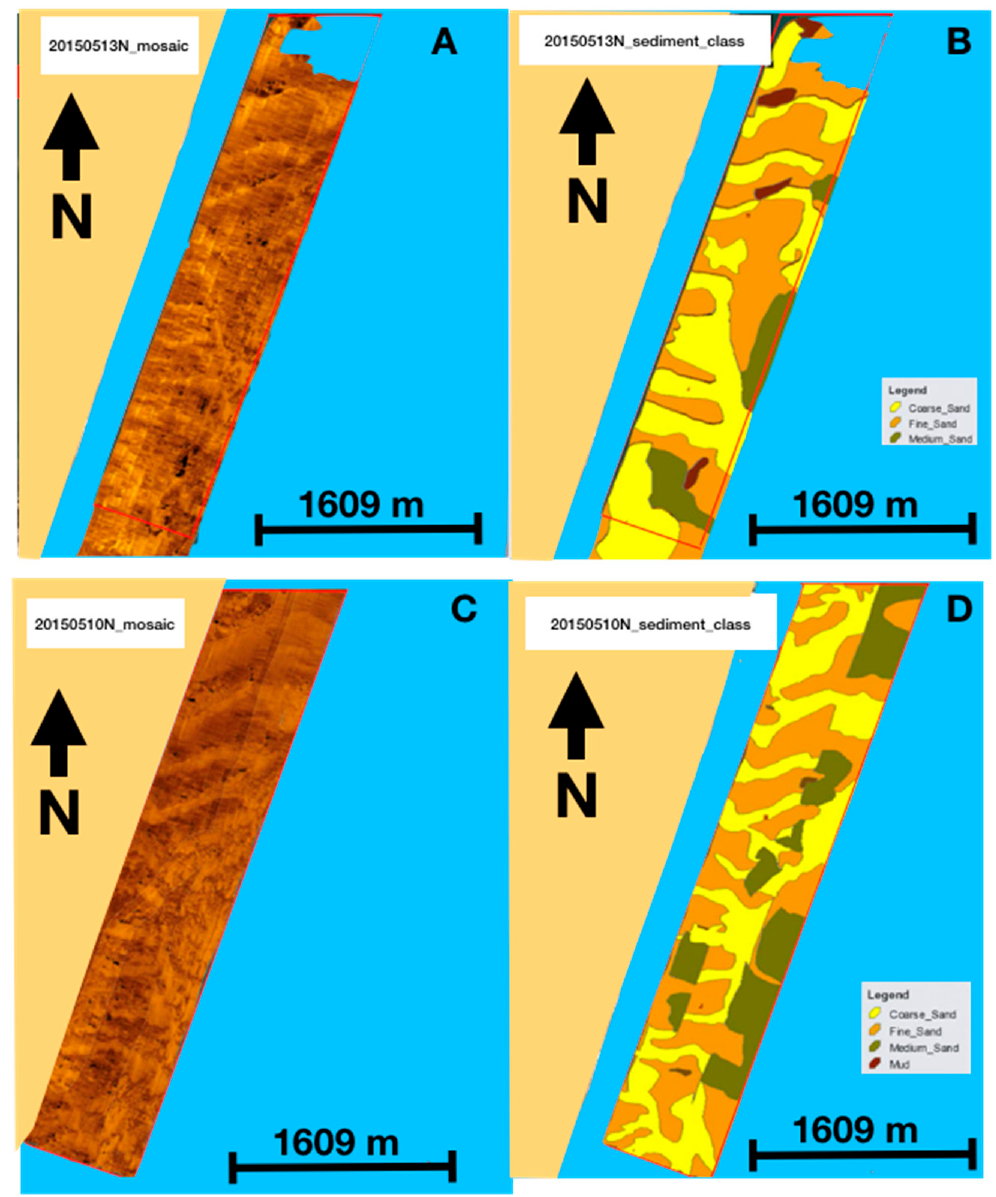
Figure 14. Side-scan sonar mosaic interpretation, Assateague Island National Seashore, Maryland ( A ) side-scan sonar mosaics collected during 13 May 2015; ( B ) interpretation of side-scan sonar data collected in 13 May 2015; ( C ) side-scan sonar mosaics collected in October 2015; ( D ) interpretation of side-scan sonar mosaics collected in October 2015. Note that red polygons represent the same areas mapped during both 13 May 2015 and October 2015.